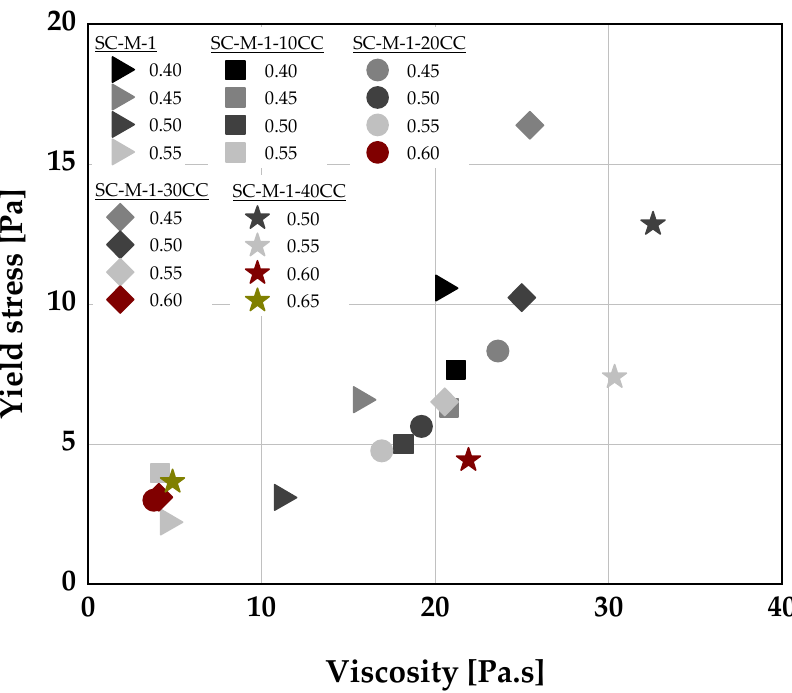
Figure 7. Comparison of yield stress and plastic viscosity of SC-M-1 with varying V cc and SP dosages.